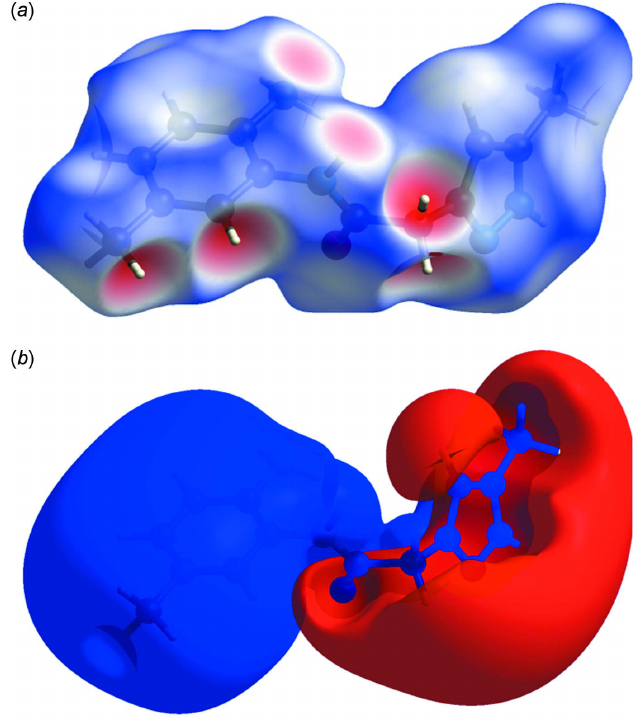
Figure 4 ( a ) View of the three-dimensional Hirshfeld surface of the title compound, plotted over d norm in the range of (cid:4) 0.6149 to 1.3177 a.u. ( b ) View of the three-dimensional Hirshfeld surface of the title compound plotted over the electrostatic potential energy in the range (cid:4) 0.0500 to 0.0500 a.u. using the STO-3 G basis set at the Hartree–Fock level of theory.